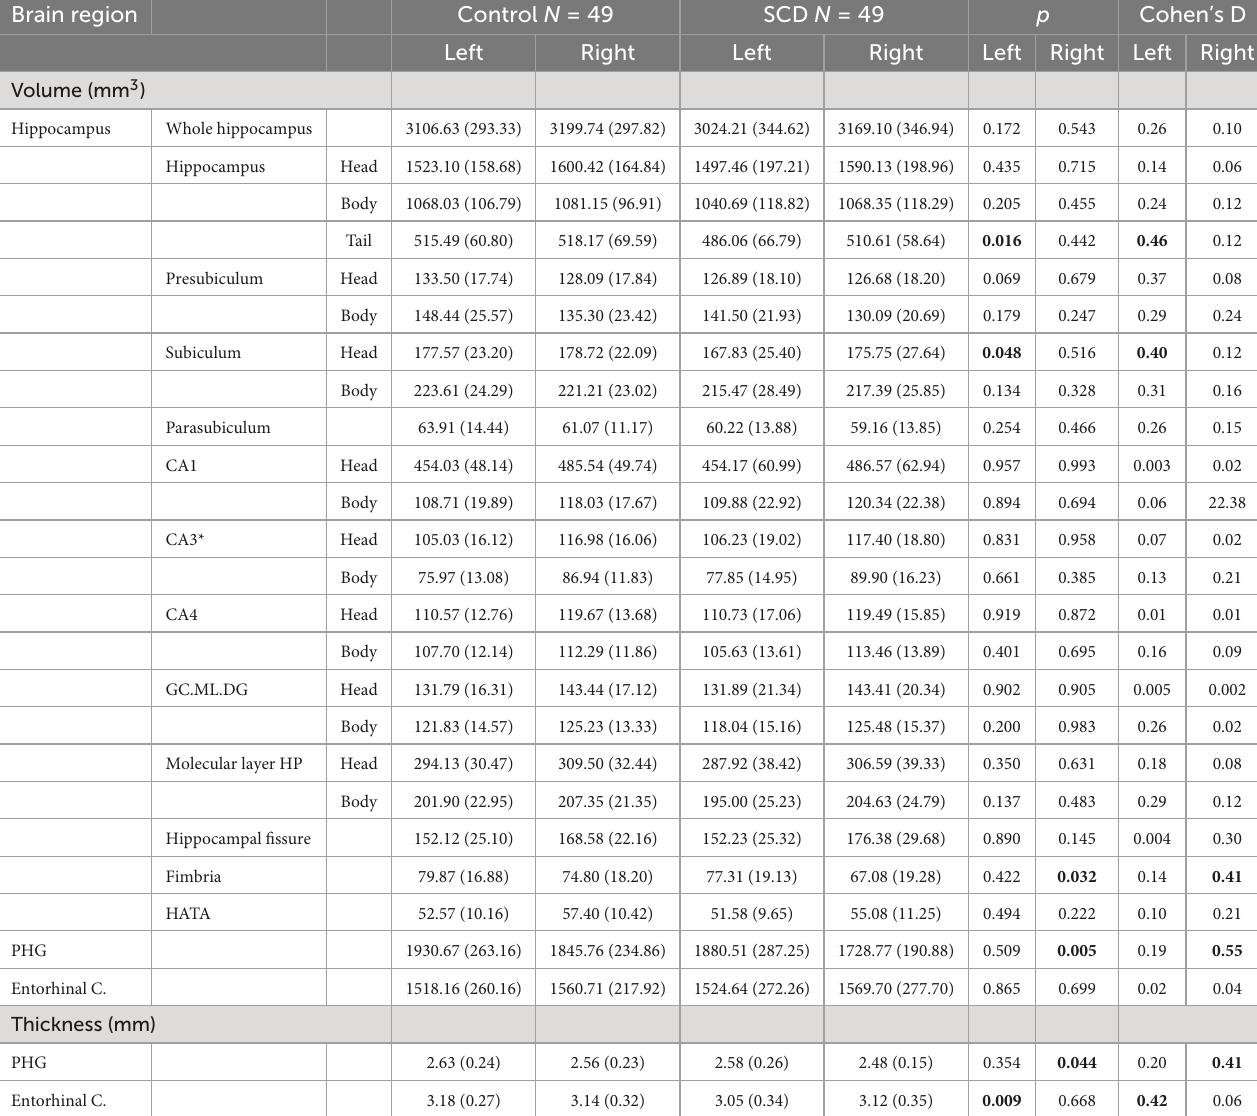
TABLE 3 Mean values and standard deviations (SD in brackets) of the adjusted hippocampal subfields measures and the surrounding medial temporal lobe areas. Brain region Control N = 49 SCD N = 49 p Cohen’s D Left Right Left Right Left Right Left